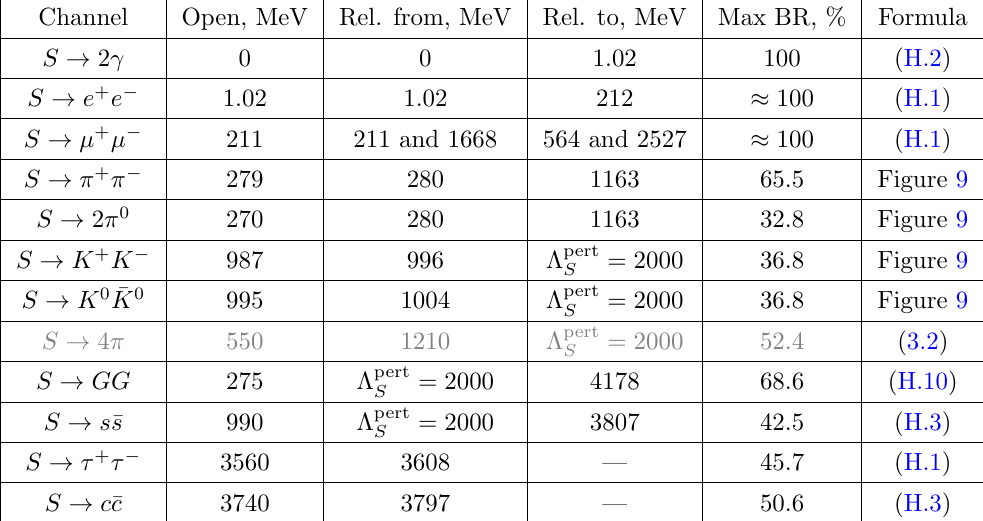
Table 5 . Relevant scalar decay channels. Only channels with the branching ratio above 1% covering the scalar mass range up to 10 GeV are shown. The gray line corresponds to the fake multi-meson channel, see discussion in text. Columns : (1) the scalar decay channel. (2) The scalar mass at which the channel opens; (3) The scalar mass starting from which the channel becomes relevant (contributes larger than 10%); (4) The scalar mass above which the channel contributes less than 10%; \|" means that the channel is still relevant at m S = 10 GeV; (5) The maximal branching ratio of the channel for m S < 10 GeV; (6) Reference to the formula (or (cid:12)gure in case of decays into pions and kaons) for the decay width of the